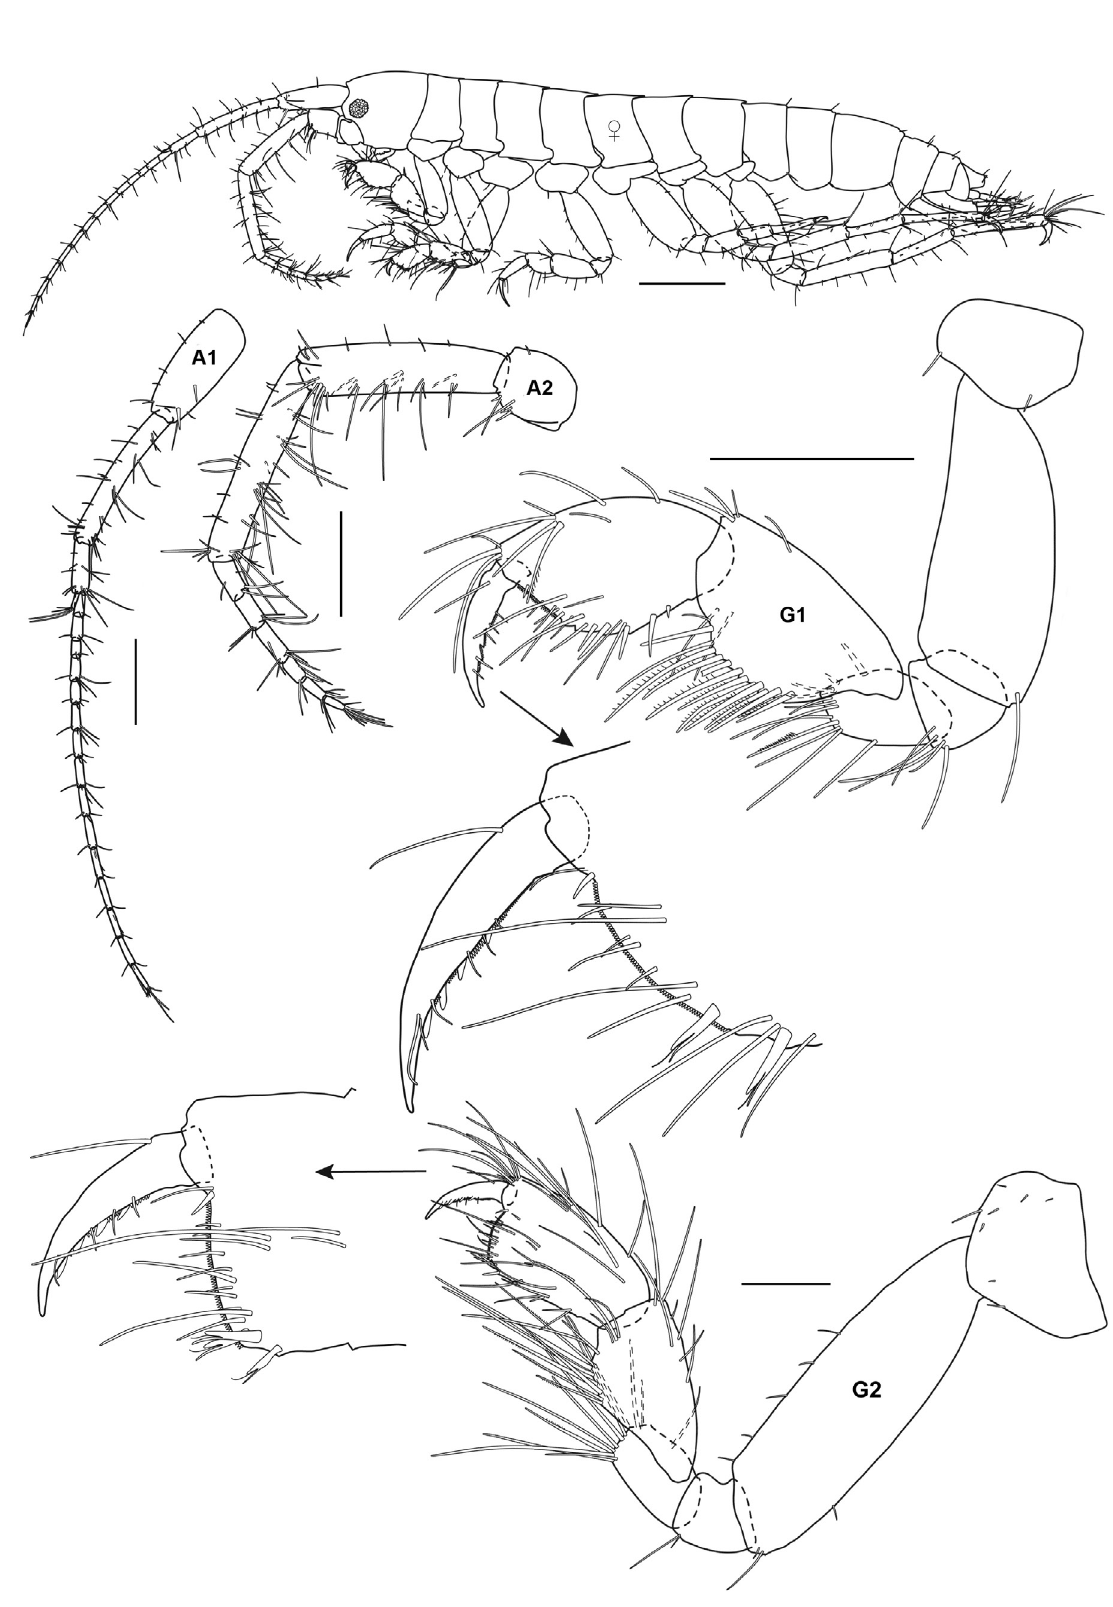
Fig. 7. Grandidierella pawaiensis sp. nov., allotype, ♀ (ZRC 2018.0494). Scale bars: 0.25